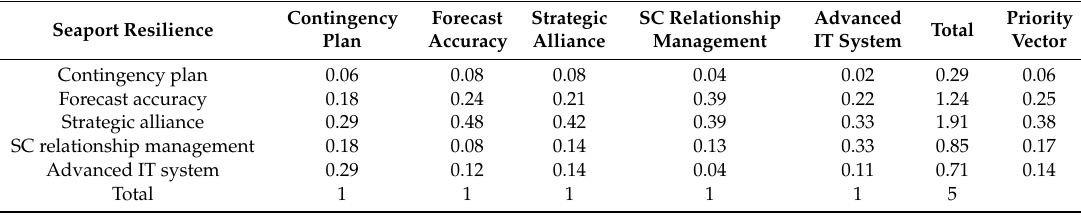
Table 6. Normalization test of port resilience criteria data.